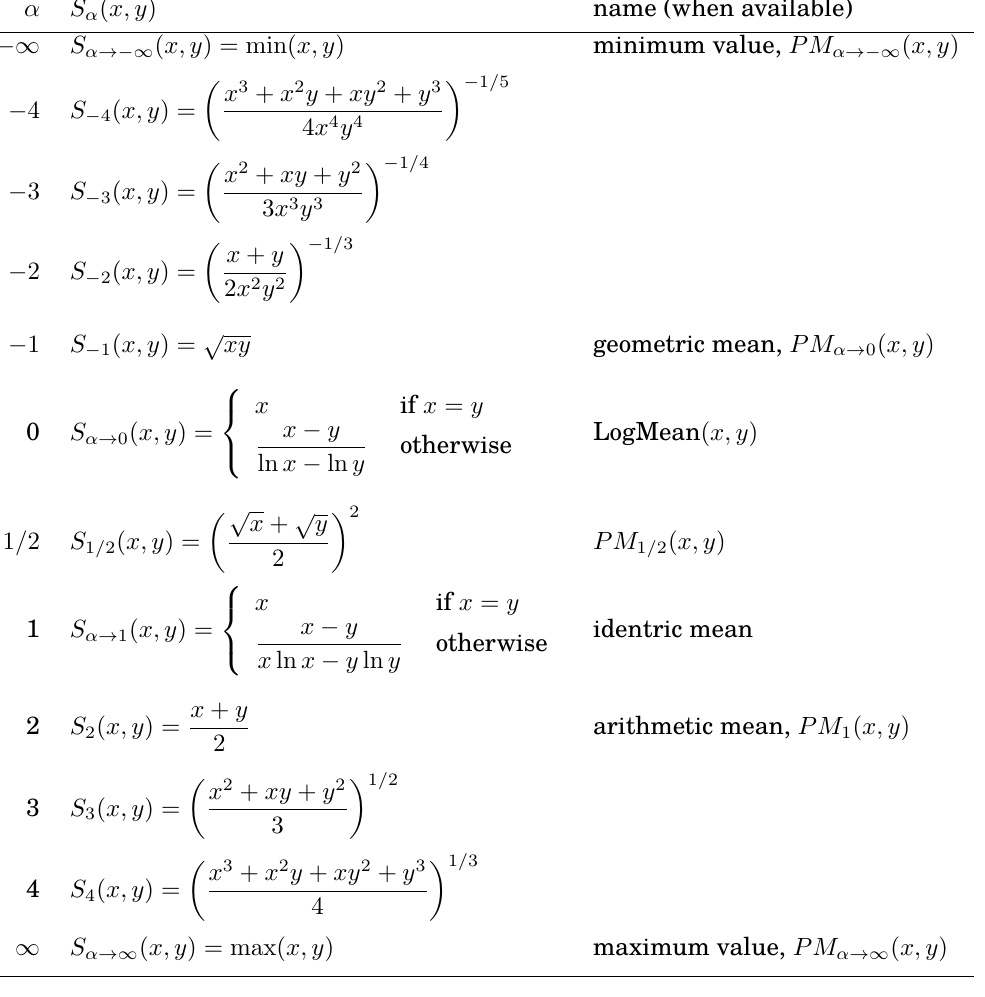
for selected values of α . α ( x, y )